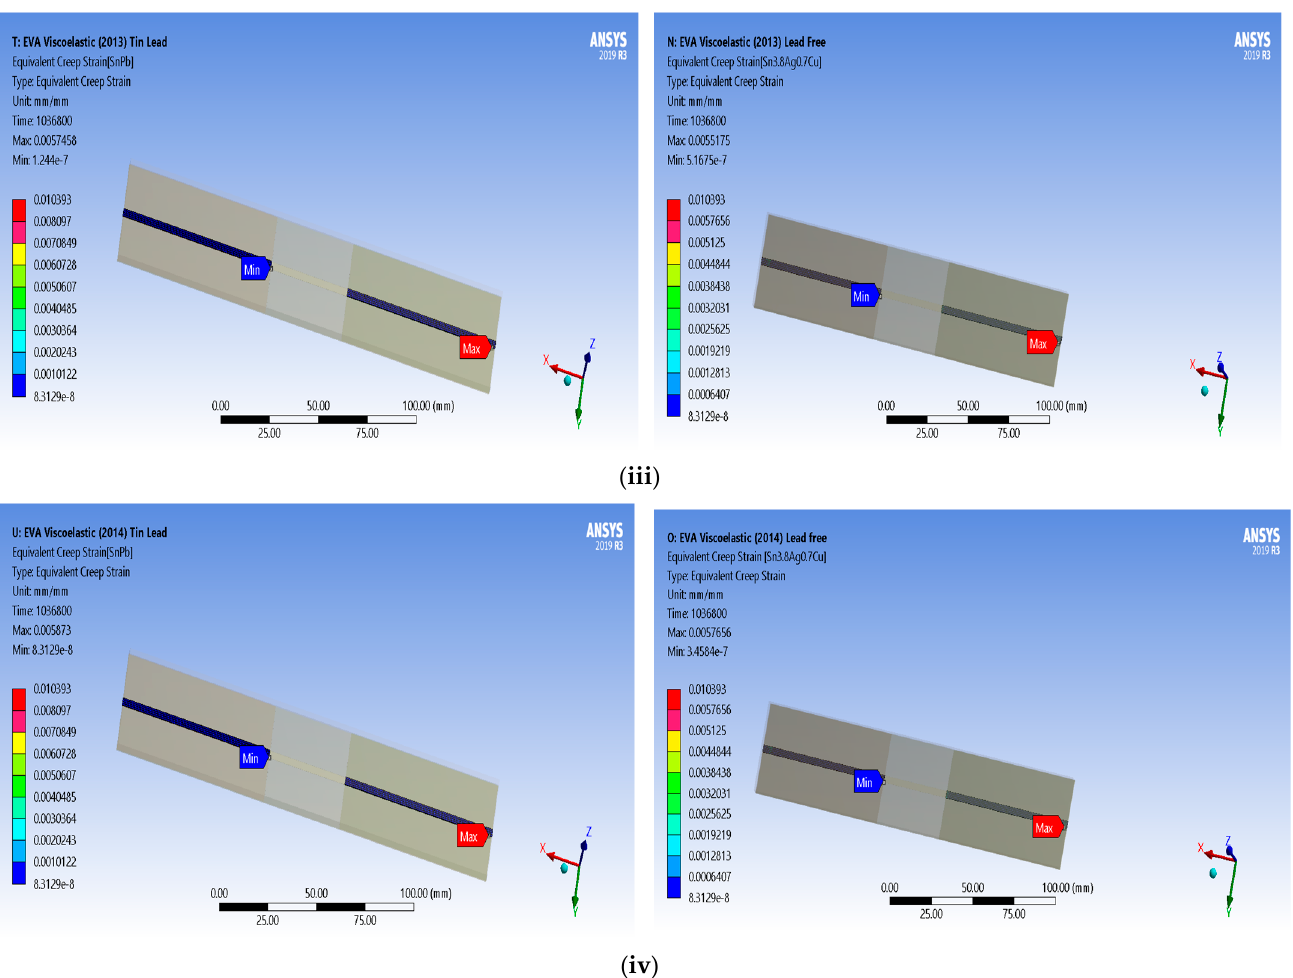
Figure 8. Equivalent creep strain distribution on PbSn solder and Pb ‐ free (Sn3.8Ag0.7Cu) solder for: ( iii ) 2013 and ( iv ) 2014 thermal cycles.